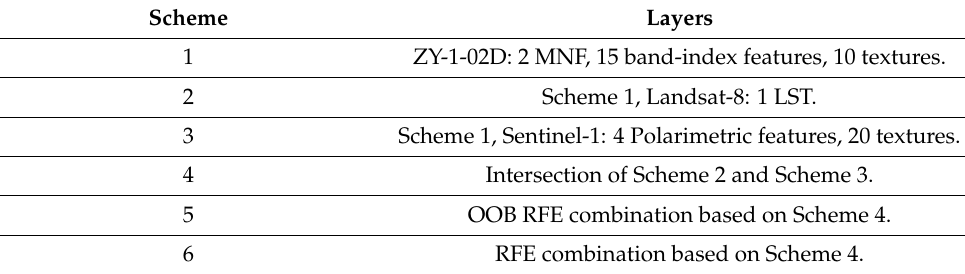
Table 4. Feature combination schemes used for classification.